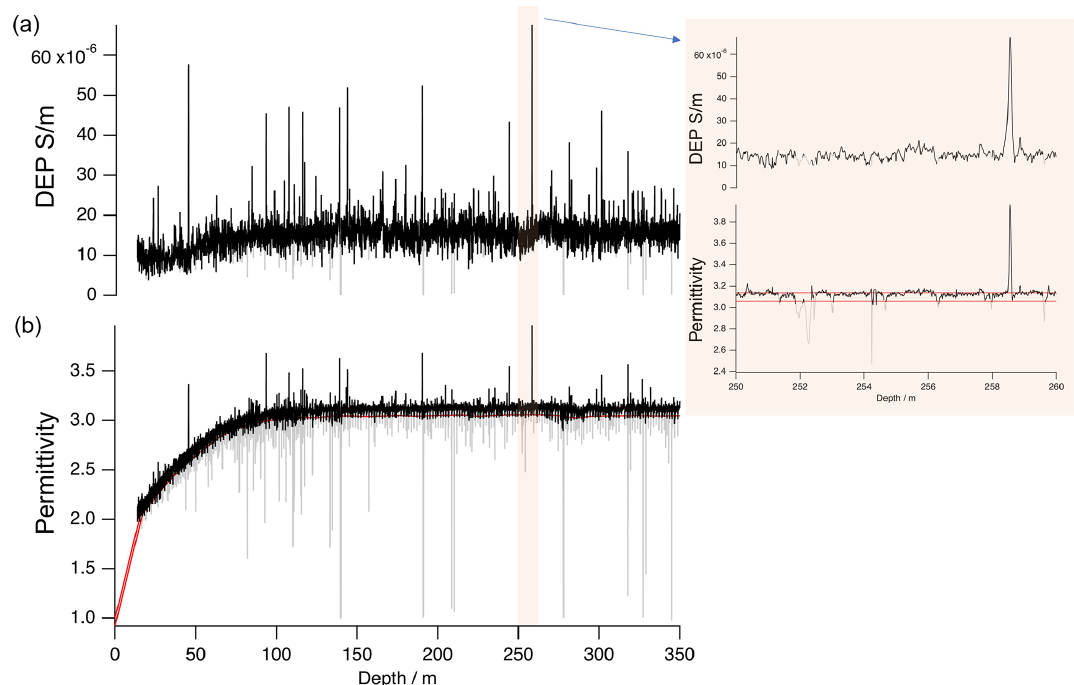
Figure 5. Example of DEP data processing (removing core breaks from the raw data). Raw data are plotted in grey and validated data are in black. We define insufficient data by permittivity drops below the threshold (indicated by the red line) and reject it during validation. Permittivity is presented in panel (a) and conductivity in (b) . The insert shows the details for a short section (250–260m).